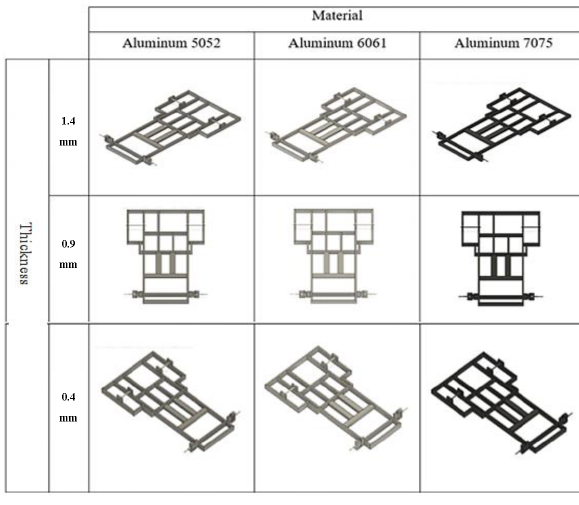
Figure 6: Variations in frame design for SEM urban vehicles